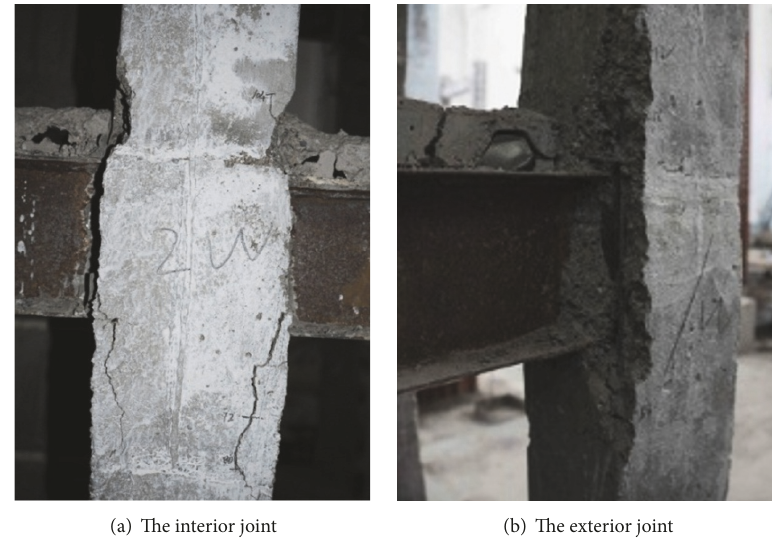
Figure 14: Cracks on joints at the second floor.